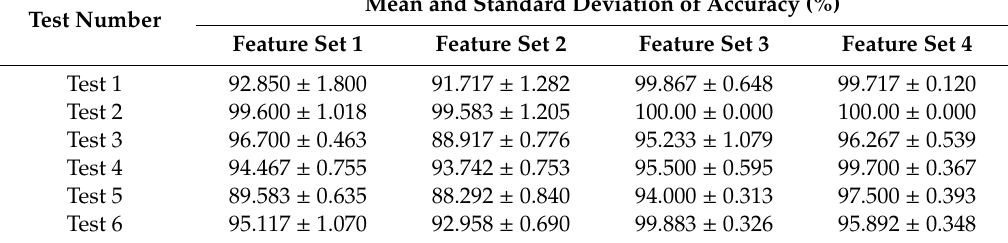
Figure 10. Accuracy (mean and standard deviation) for the internal and external test sets under ten independent experiments: ( a ) accuracy (mean and standard deviation) for internal test set; ( b ) accuracy (mean and standard deviation) for external test set. Table 6. Accuracy (mean and standard deviation, %) of internal testing with 10 independent and random trials.